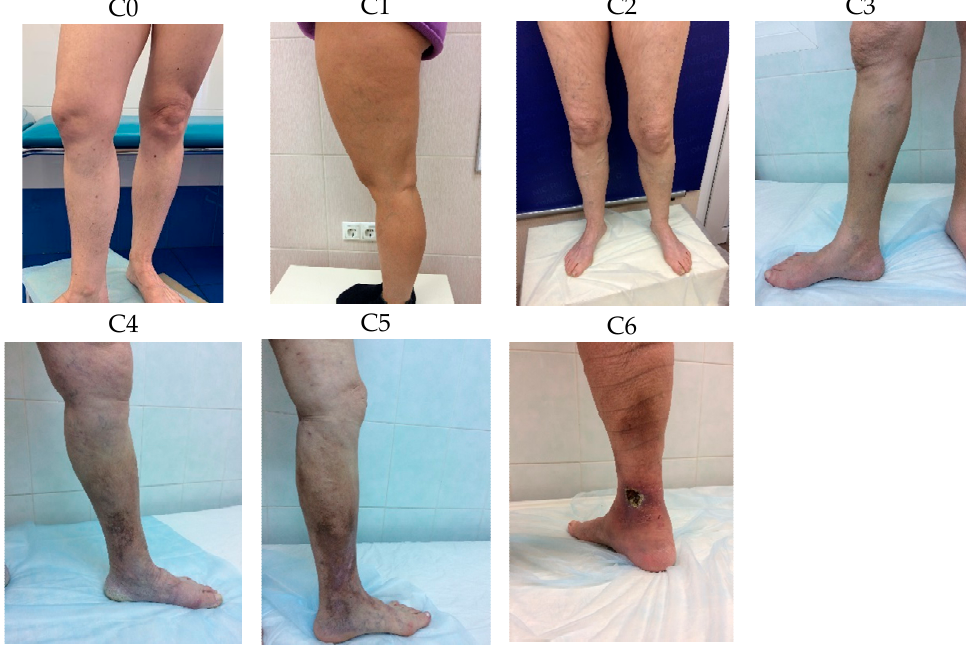
Figure 3. Images of legs with CVD.